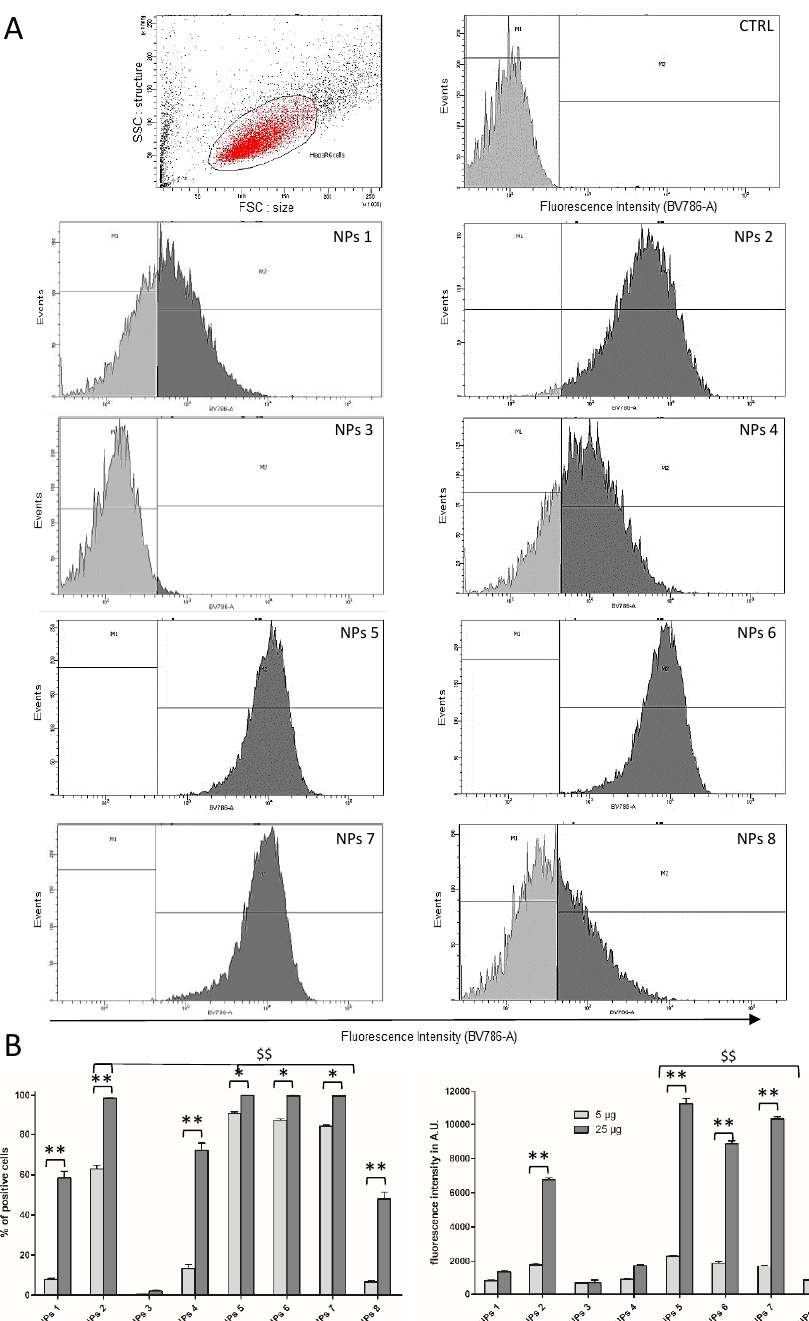
Figure 2. ( A ) Dot plot (control HepaRG cells) and histograms used to detect negative (M1 gate) and positive (M2 gate) cells and determine the mean of fluorescence in control (CTRL) and cells incubated with nanoparticles (NPs) 1 to 8; ( B ) Quantification of percentages of positive cells and mean of fluorescence in progenitor HepaRG cells incubated with PMLABe-based nanoparticles for 24 h. Statistical analyses: ** p < 0.01: cells incubated with 5 µg/mL of polymers versus cells incubated with 25 µg/mL; $$ < 0.01: highest percentages of positive cells or mean of fluorescence versus all the other conditions.